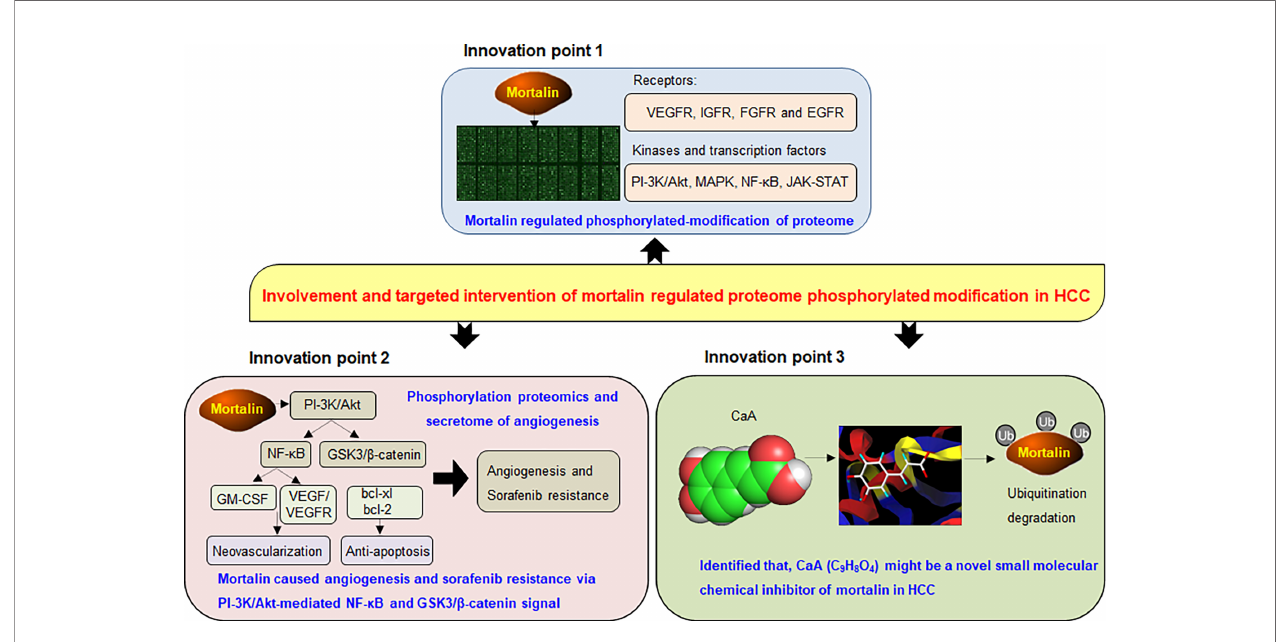
FIGURE 7 | A sketch map summarizing the conclusions, innovations, and potential clinical signi fi cance of our present